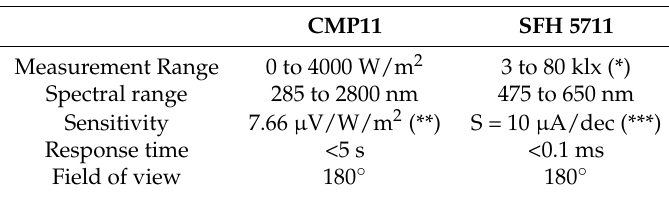
Figure 2. Six examples of real irradiance profiles used for calibration. The starting dates and times expressed in UTC+2 in each case: ( a ) 7 June 2018 13:20:42; ( b ) 8 June 2018 11:21:49; ( c ) 9 June 2018 09:48:22; ( d ) 9 June 2018 10:44:52; ( e ) 10 June 2018 12:35:15; and ( f ) 11 June 2018 11:00:46. Table 1. Specifications.